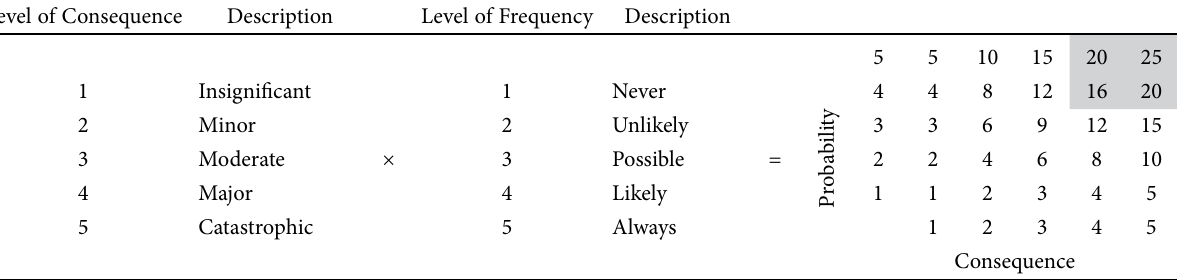
Figure 2. Example of a quantitative risk matrix (Zolfagharian et al.,